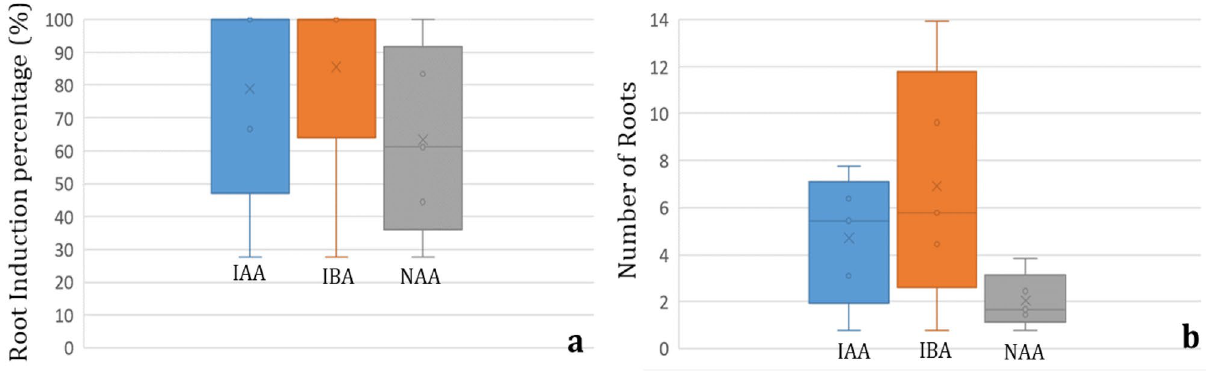
Figure 4. Box plots representing the effect of different media combinations on; ( a ) root induction percentage, ( b ) number of roots per